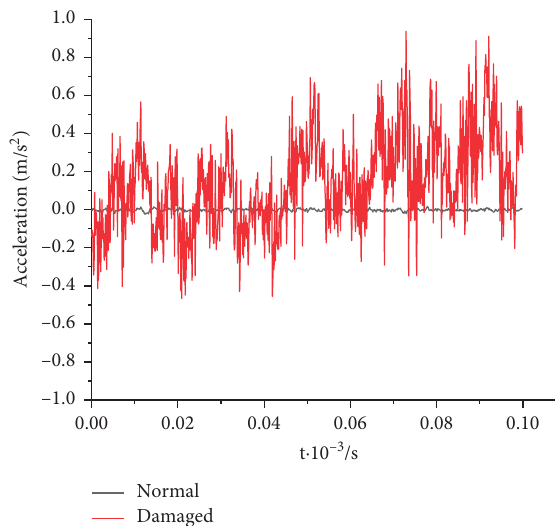
Figure 3: Axial vibration time-domain diagram of vibration